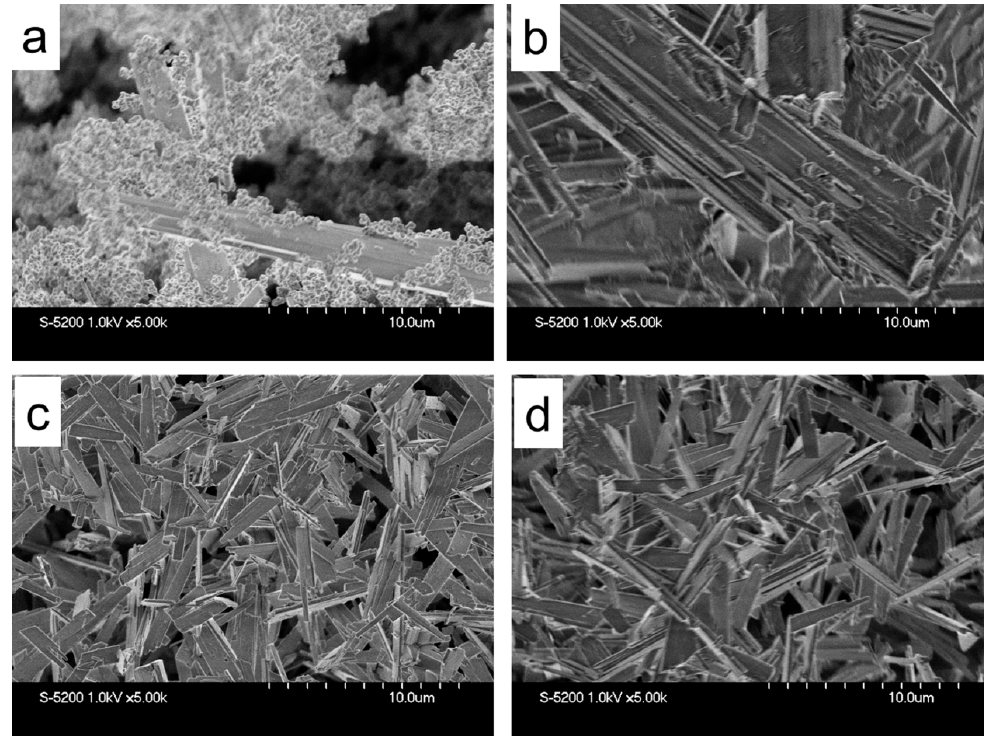
Figure 2. SEM images of ( a ) Ti-CIT-5[HF]-13d, ( b ) Ti-CFI[NH 4 F]-13d, ( c ) Ti-CFI[HF]-seed-7d, and ( d ) Ti-CFI[HF]-seed-13d.